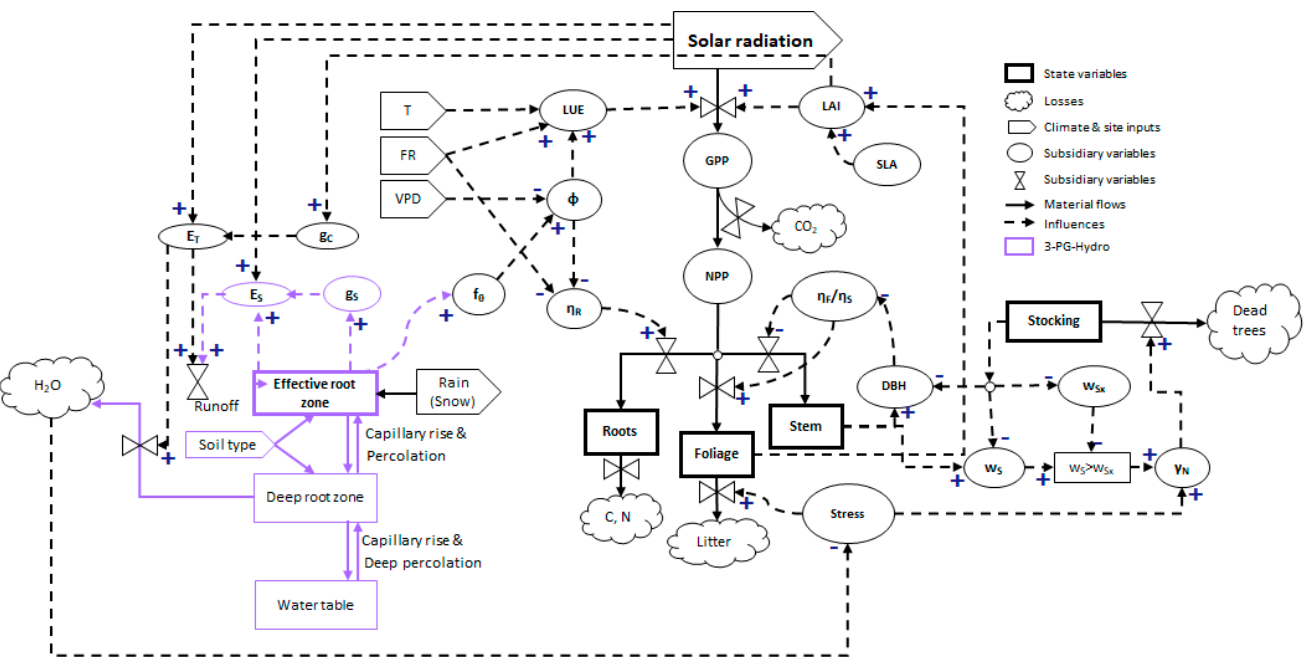
Figure 1. Schematic overview of 3PG ‐ Hydro reproduced, adapted and modified from Meyer et al. (2018) [13], with permission from Elsevier, 2021.